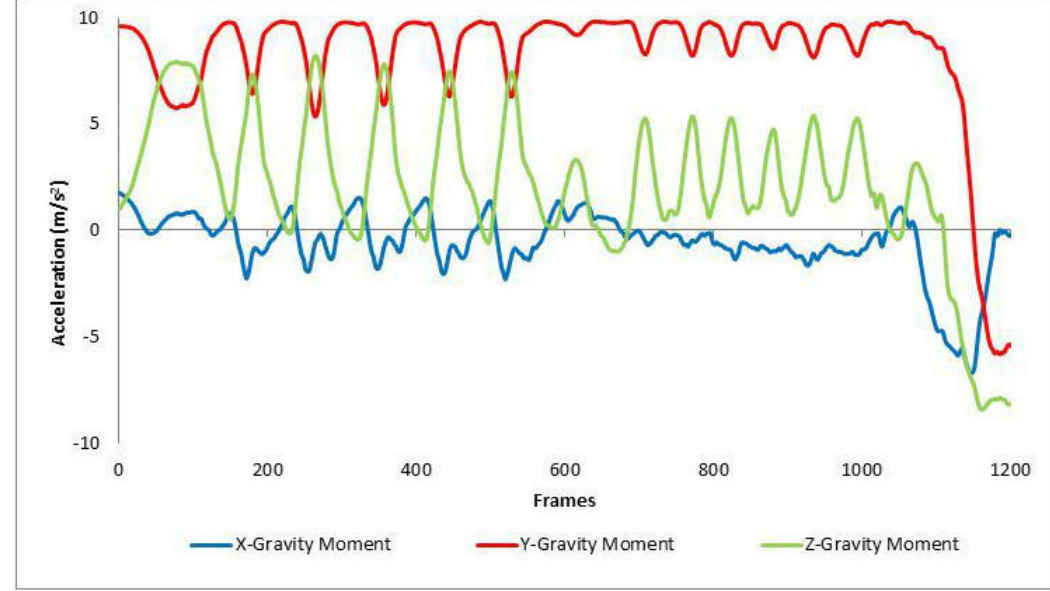
Table 1. Descriptive statistics of Chair Stand Test and Stair Climb Test with comparisons between app-derived data and human-observed data.